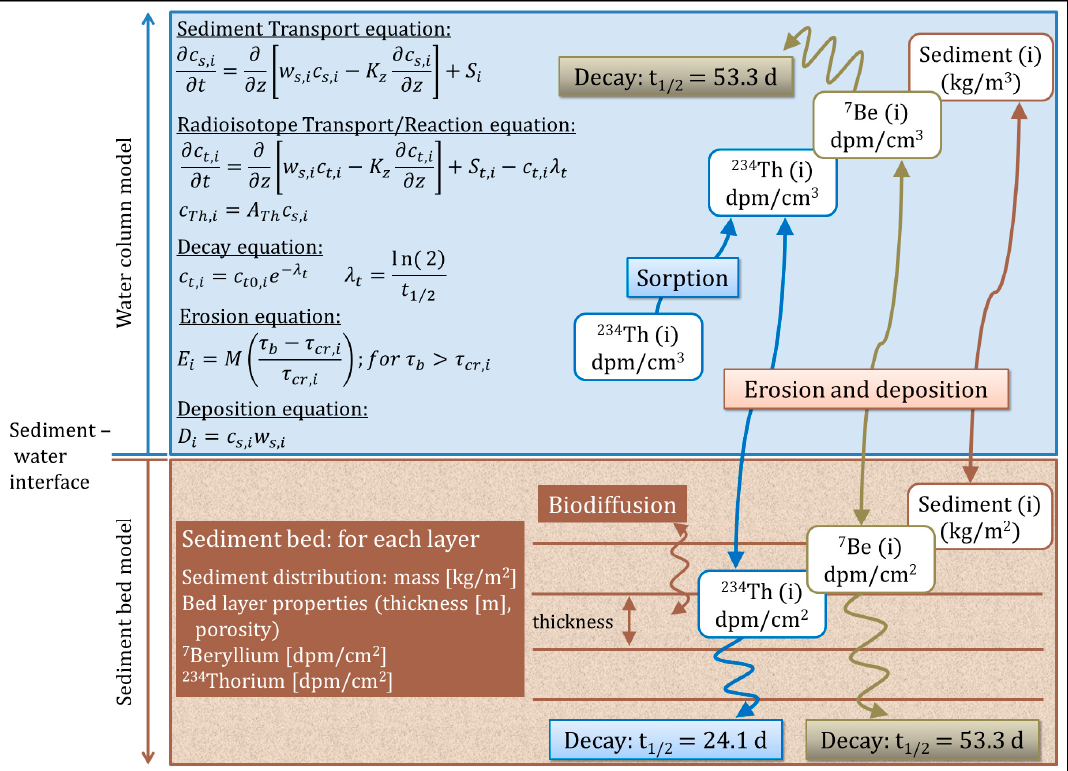
Figure 1. Schematics of the sediment transport and geochronology model. Water column layers (blue) overlie seabed layers (brown) of variable thickness. Shaded boxes indicate processes; white boxes indicate state variables (tracers).